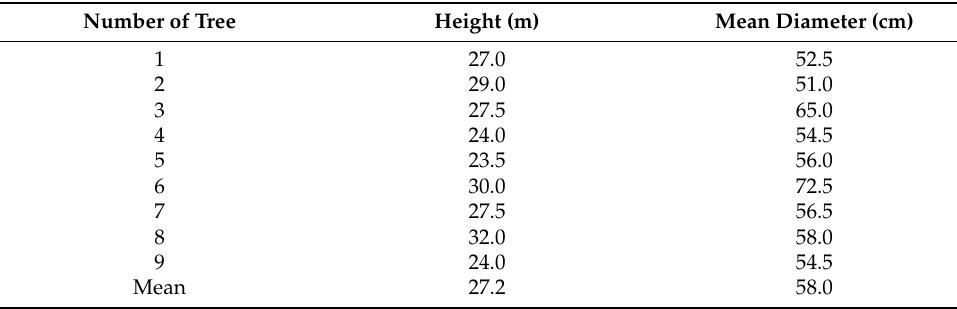
Table 1. Characteristics of selected